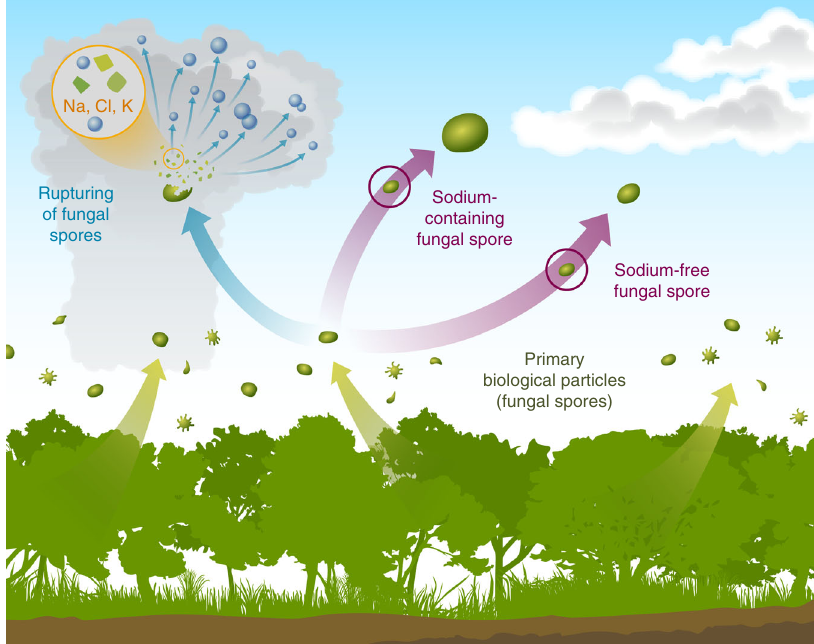
Fig. 4 Sources and atmospheric processing of fungal spore particles in the Amazon rainforest. Sodium-containing and sodium-free fungal spore particles are emitted from the Amazon rainforest. Sodium-containing fungal spores exhibit higher hygroscopic growth compared to sodium-free fungal spores. When they are exposed to high humidity conditions, or through cloud processing, fungal spore particles rupture and release submicrometer-to-micrometer size fragments. A substantial fraction of the fragments contain Na, Cl, and K, and appear morphologically similar to dry sea salt particles.